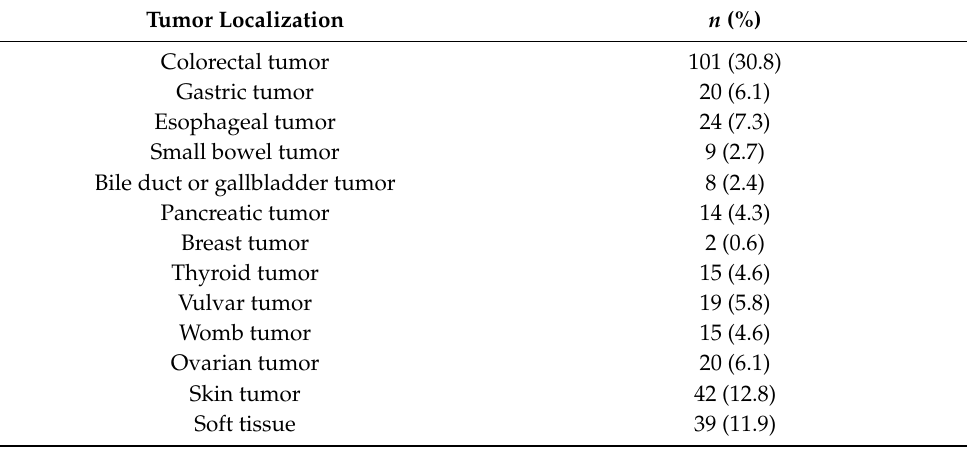
Table A1. Specification of the different tumor locations of the included patients ( n = 328).